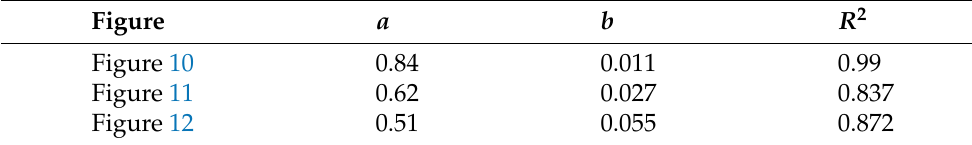
Table 8. Quality of Regression of Attack Success Probability to P = a exp bx .